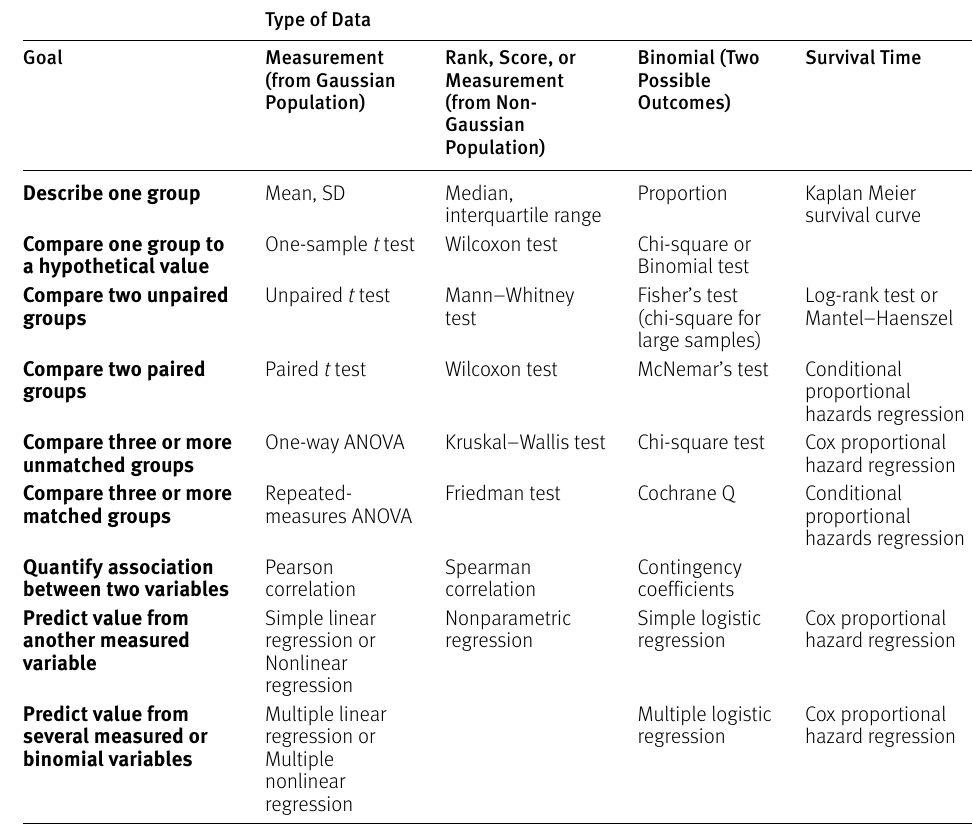
Table 1. Road map for the use of statistical